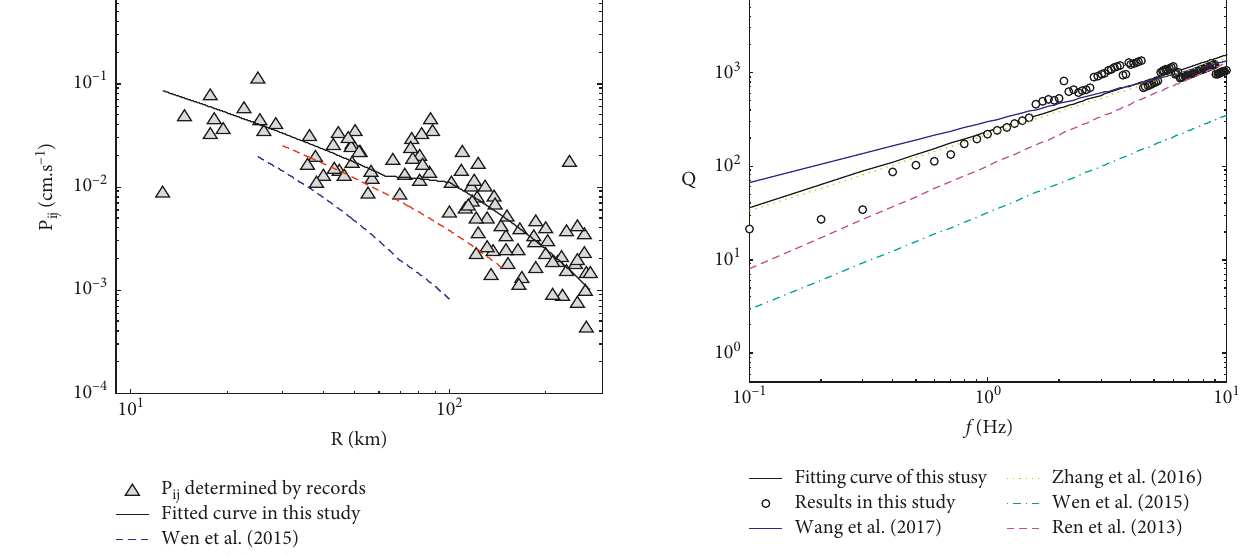
Figure 9: Quality factor Q for Changning earthquake region.